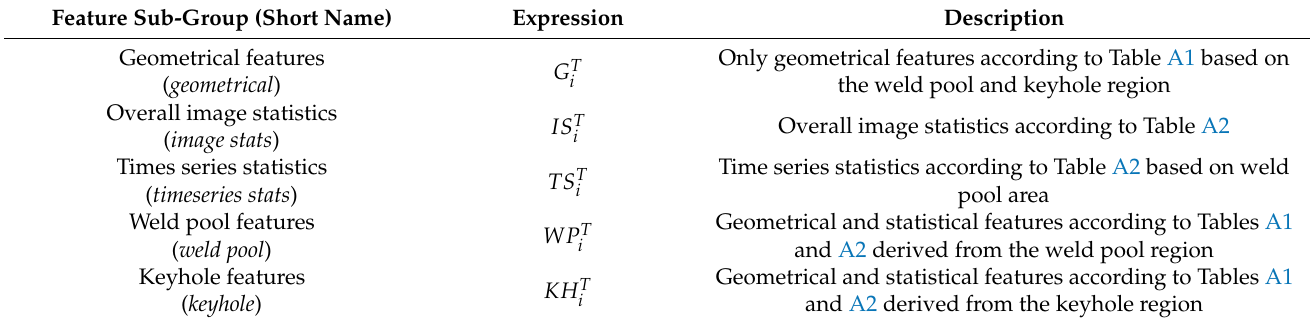
Table 2. Description of feature sub-groups used for classical machine learning methods and feature importance evaluation. Feature Sub-Group (Short